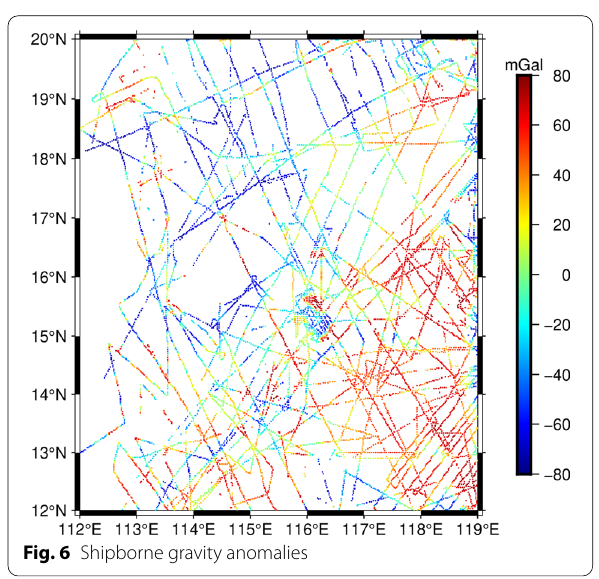
Fig. 6 Shipborne gravity anomalies